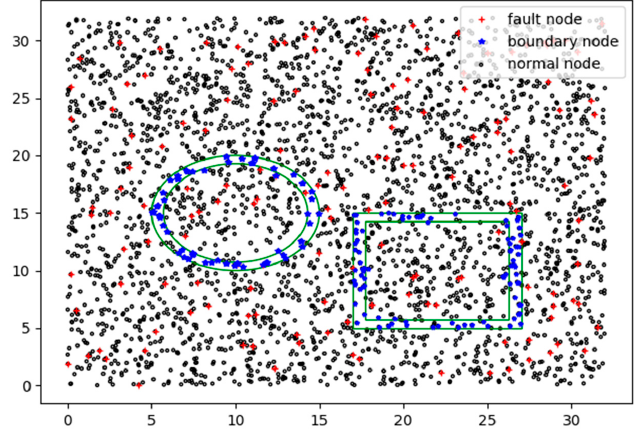
Figure 10. An experimental snapshot.